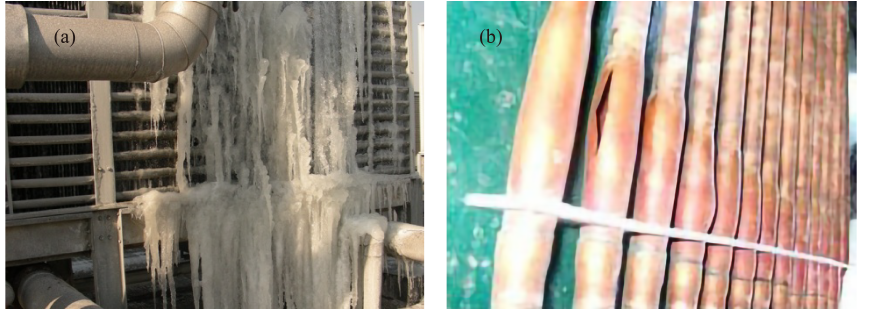
Figure 1. The impacts of cooling tower freezing. ( a ) Hanging ice at the air inlet. ( b ) The cracked